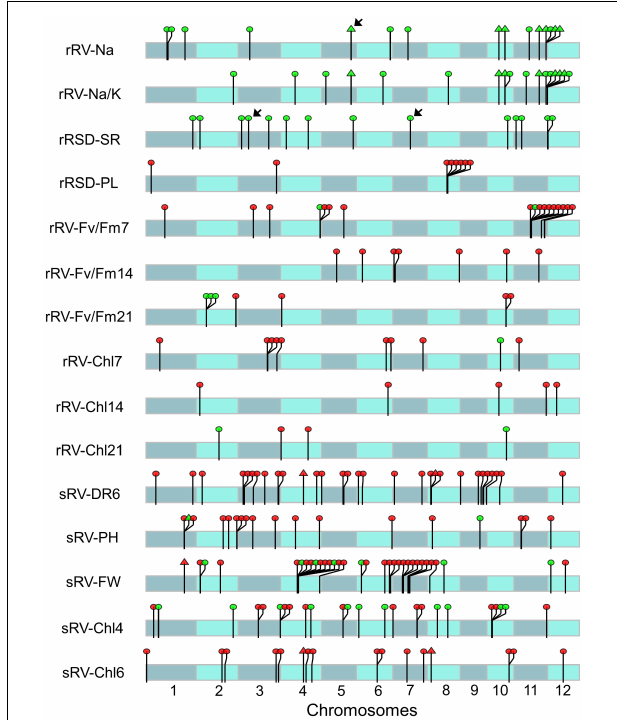
FIGURE 2 | Distribution of significant single nucleotide polymorphisms (SNPs) associated with different ST indices on chromosomes. Red and green dots indicate the corresponding SNP explained phenotypic variation less than 10% and more than 10%, respectively. The arrows indicate the SNPs explain more than 14% total phenotypic variation of the corresponding ST index. Triangles indicate the SNPs associated with two different ST indices. The length of chromosome was dimensionally drawn based on the physical length of each chromosome